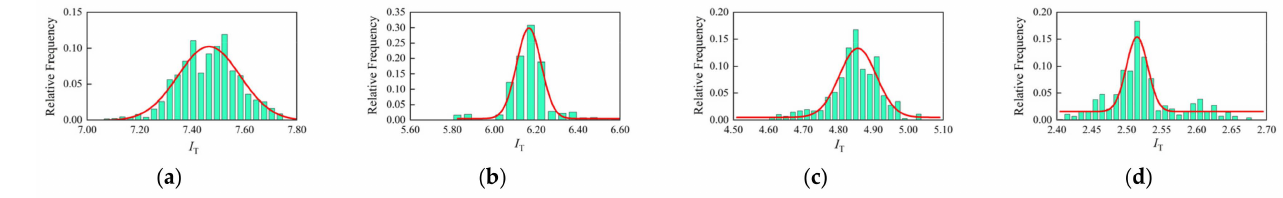
Figure 12. Posteriori relative frequency distribution of member 146. ( a ) Healthy; ( b ) mild injury; ( c ) moderate damage; ( d ) severe